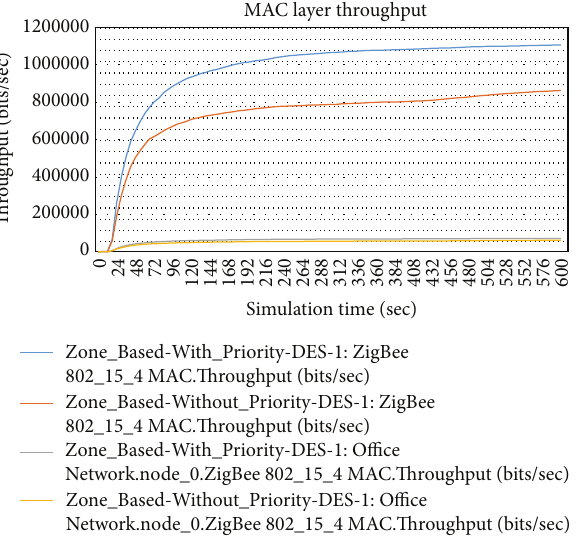
Figure 3: MAC delay (sec) for global model and Coordinator (node 0).